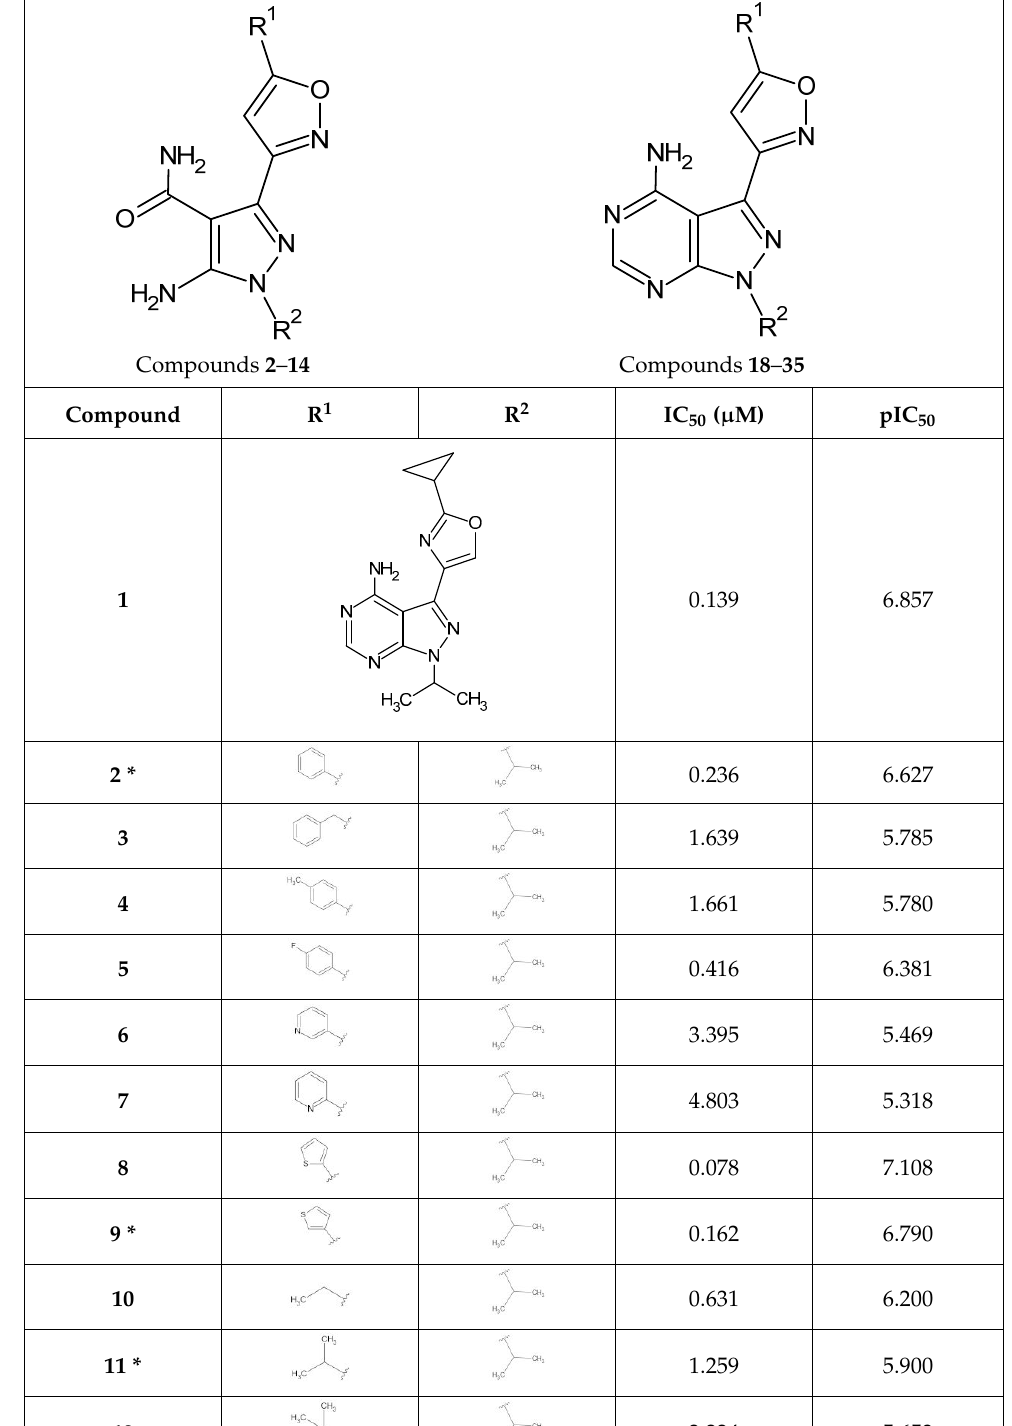
Table 4. The chemical structures of the pyrazole derivatives with their IC 50 and pIC 50 values.